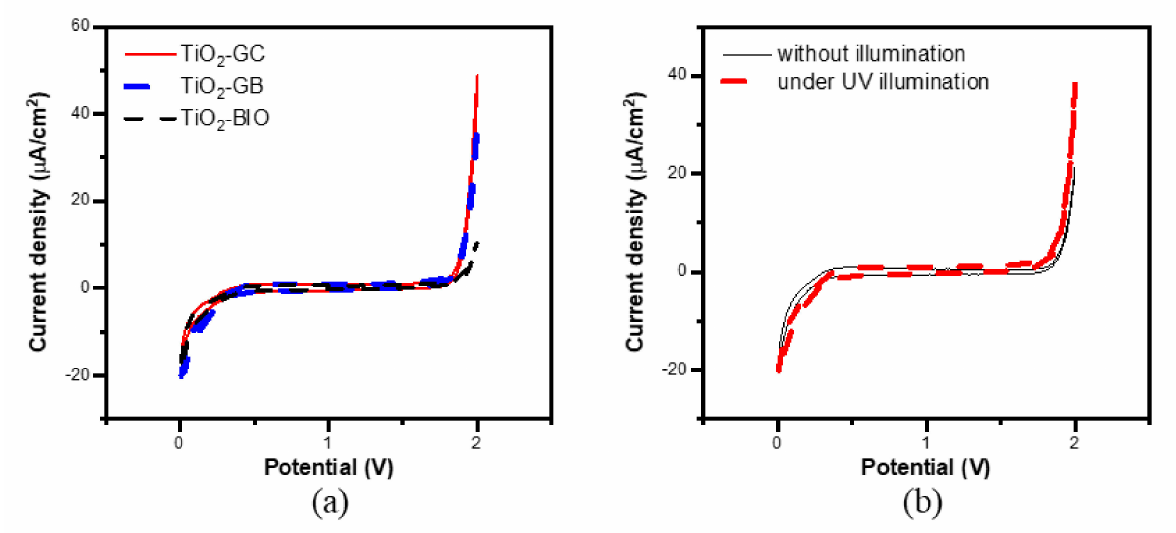
Figure 11. Cyclic voltammetry under UV light: ( a ) All the samples under UV illumination; ( b ) Difference between with and without UV illumination for TiO 2 -GB as